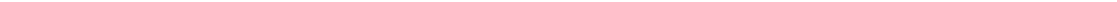
Fig. 7 Eliminating cis P-tau in rmTBI mice with cis mAb prevents the development of a range of pathological features resembling those found in human CTE. Mice were subjected to seven mild TBI events over 9 days and were treated with cis mAb or IgG isotype control over 4 months, followed by 2 months of washout, before assaying pathologies in different brain regions a , b . Blue arrows, rmTBI; black arrows, antibody injection; green line, functional, or pathological assays. Cis mAb treatment of rmTBI mice eliminated induction and spreading of cis P-tau and total tau c , d , prevented the development and spreading of axonal pathology e , tau oligomerization f , APP accumulation g , GFAP-positive astrocyte h , Iba-positive microglia i , TDP-43 pathology with increased cytoplasmic mislocalization of TDP-43 j − l . Line graphs showing the relative IF intensity of TDP-43 across a single cell k , l (Blue line, DAPI; red line, TDP-43). Cis mAb treatment also prevented the demyelination as detected by CNPase IF m , n , and neuronal loss o in different brain regions. Shorter exposure of ECL for total tau immunoblots in c was used due to a huge increase in total tau in rmTBI mice, as expected because cis P-tau is resistant to protein degradation. Microscope images corresponded to the medial prefrontal cortex of sham (left), rmTBI + IgG (middle), and rmTBI + cis mAb (right) with quanti fi cation data in different brain regions being present at right panels. Inset images are the high magni fi cation image of selected area denoted by the white. Scale bar, 40 μ m. Red arrows point to axonal bulb in Gallyas silver staining. mPFC, medial prefrontal cortex; HC, hippocampus; Thal, thalamus; BLA, basolateral amygdala; CC, corpus callosum; IC, internal capsule; Cb, cerebellum. ND, not detectable; NS, not signi fi cant. Brains from 4 − 5 WT male mice were studied in immunohistochemistry per group. The data are presented as means ± SEM. The p -values were calculated using unpaired two-tailed parametric Student ’ s t -test. * p < 0.05, ** p < 0.01, *** p < 0.001, **** p <